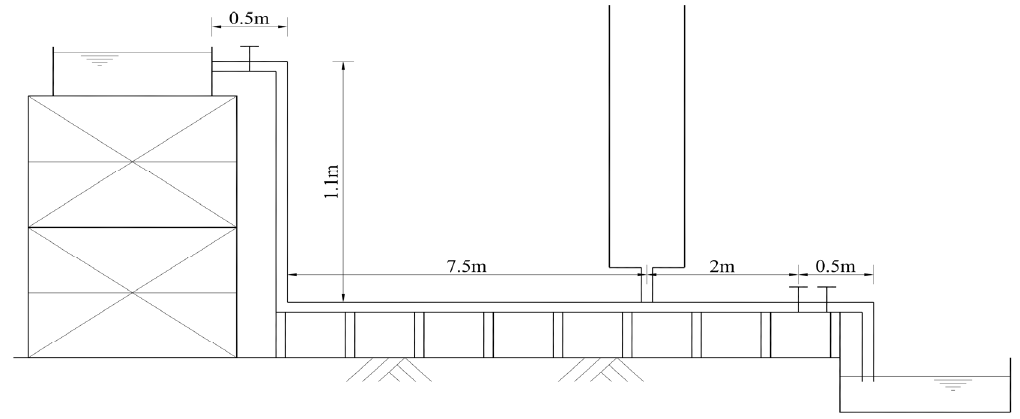
Figure 3. The experimental equipment. ( a ) is the graph of piping system and ( b ) is the graph of pressure sensor Table 1. Parameters of the experimental pipeline.